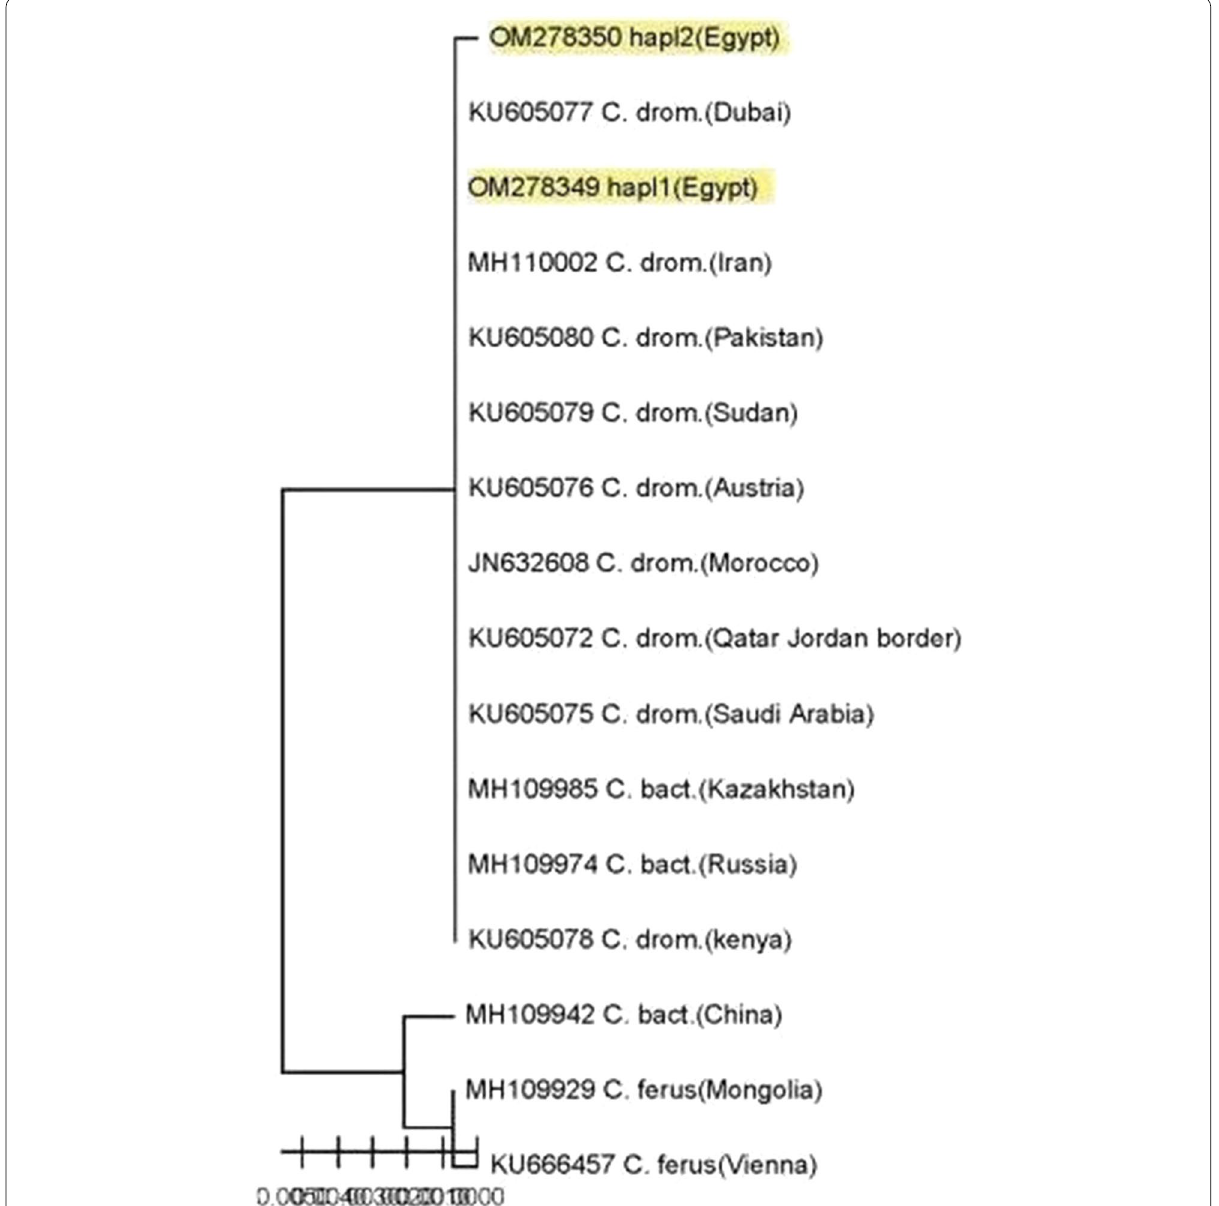
Fig. 4 Phylogeny tree constructed by neighbor‑joining method among camel populations in Egypt and published sequences using MEGA 11 computed using the Kimura two-parameter model using 1000 bootstrap